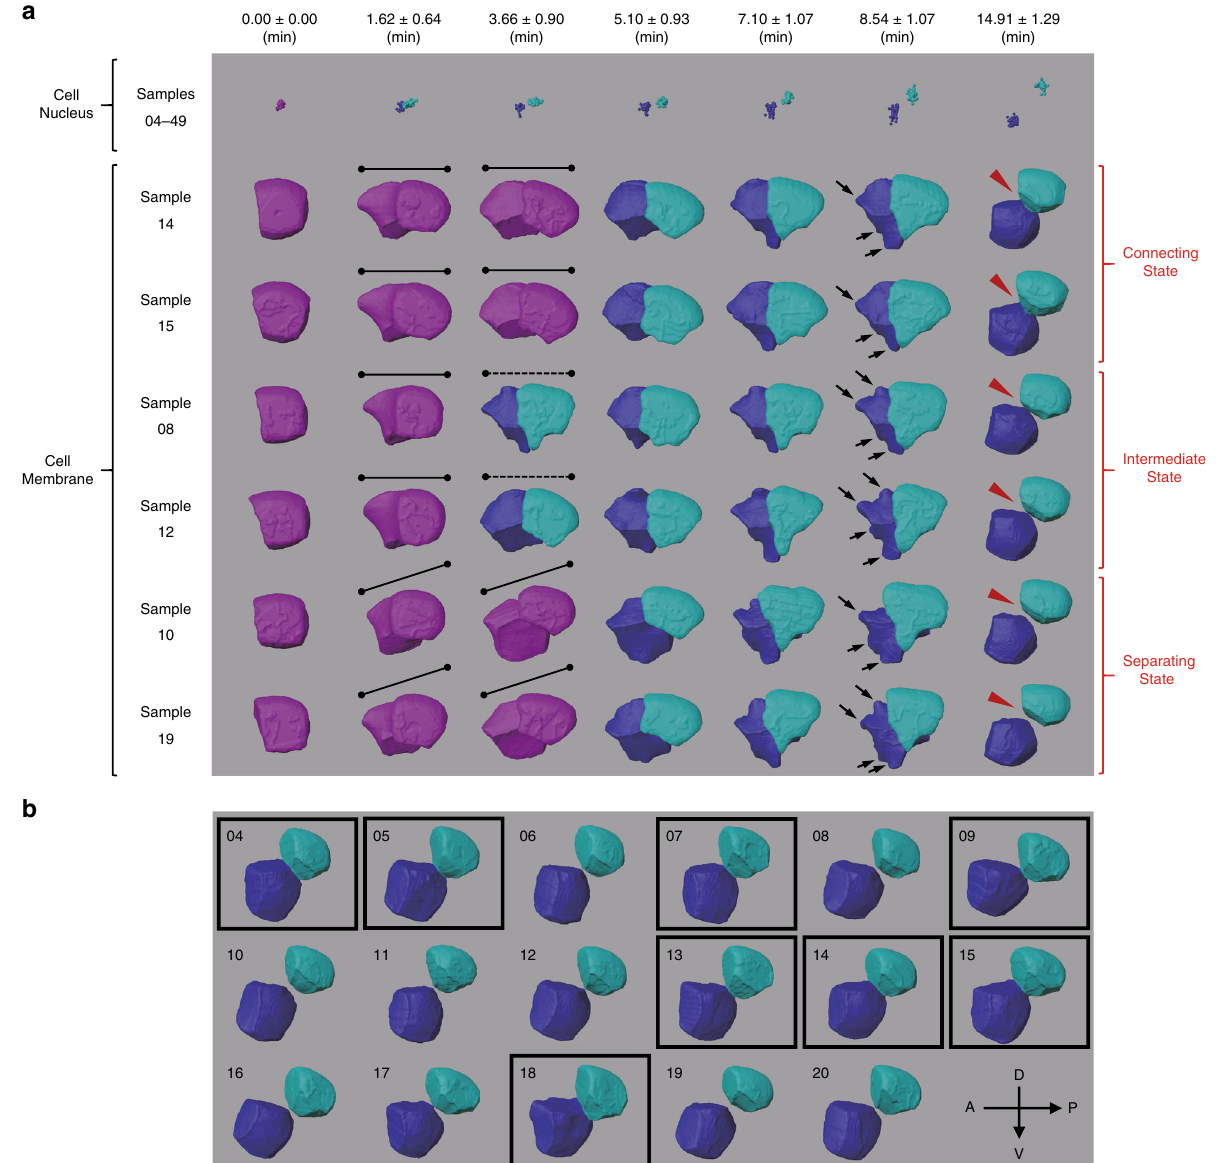
Fig. 5 Morphological dynamics at single-cell resolution. Time-lapse 3D cell shapes during C. elegans embryogenesis for ABp (purple) and its daughter cells, ABpl (blue) and ABpr (cyan). Horizontal and vertical axes represent anterior – posterior (A – P) and dorsal – ventral (D – V) axes, respectively. a Morphological dynamics are shown as in Fig. 4c for the time points immediately before and after AB2 divisions (columns 1 – 2), before and after EMS division (columns 3 – 4), before and after P2 division (columns 5 – 6) and before AB4 divisions (column 7) (Supplementary Data 2). The fi rst row shows the cell position (nuclei) distributions obtained from all 46 wild-type embryo samples (04 – 49). The second to seventh rows show reconstructed cell morphologies from embryo samples segmented with membrane markers. Embryo Samples 08, 10, 12, 14, 15, and 19 were selected to demonstrate the morphological dynamics of ABp and its daughter cells. Note that in the second and third columns the division orientation of ABp is marked by solid and dashed lines for unseparated and separated daughter cells, respectively. In the sixth column, sharp humps on the ABpl ’ s surface are highlighted by black arrows. In the last column, ABpl and ABpr can be observed in a connecting state, intermediate state or separating state, exempli fi ed by Samples 14 and 15, Samples 08 and 12, Samples 10 and 19, respectively. b Position and morphology of ABpl (blue) and ABpr (cyan) at the time point prior to AB4 divisions. The embryo samples with ABpl-ABpr cell pairs in a connecting state are highlighted by black